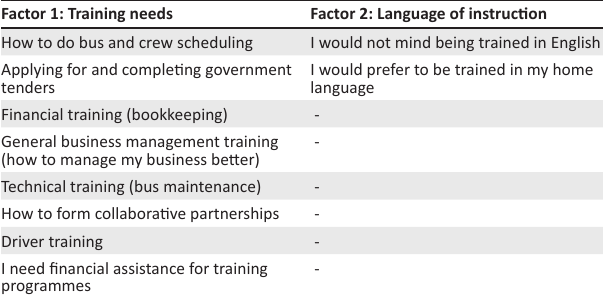
TABLE 5: Factor loadings after rotation: Training needs. Factor 1: Training needs Factor 2: Language of